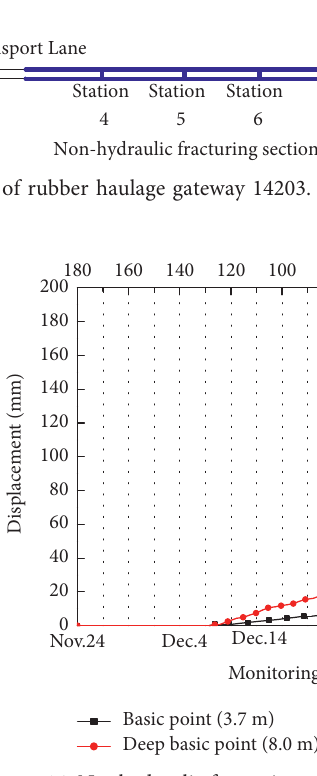
Figure 12: Nonhydraulic fracturing section: displacement varia- tion of surrounding rock monitored by 5# station.